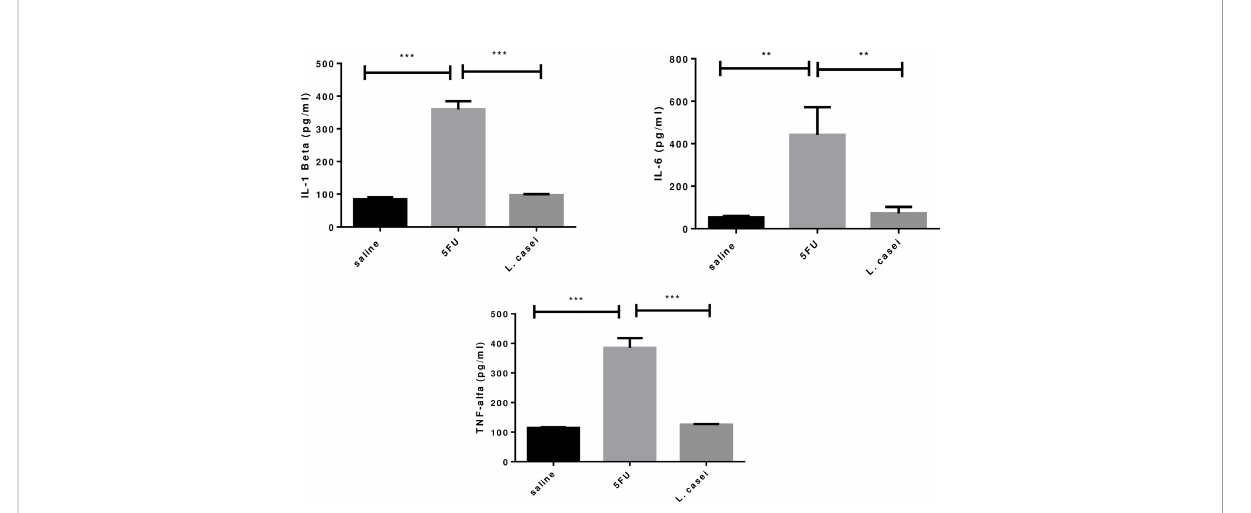
FIGURE 6 IL-1 beta, IL-6, TNF- a levels. Groups: Saline, 5FU (5- fl uorouracil) and L. Casei ( Lacticaseibacillus case ). ** p < 0.01, *** p <